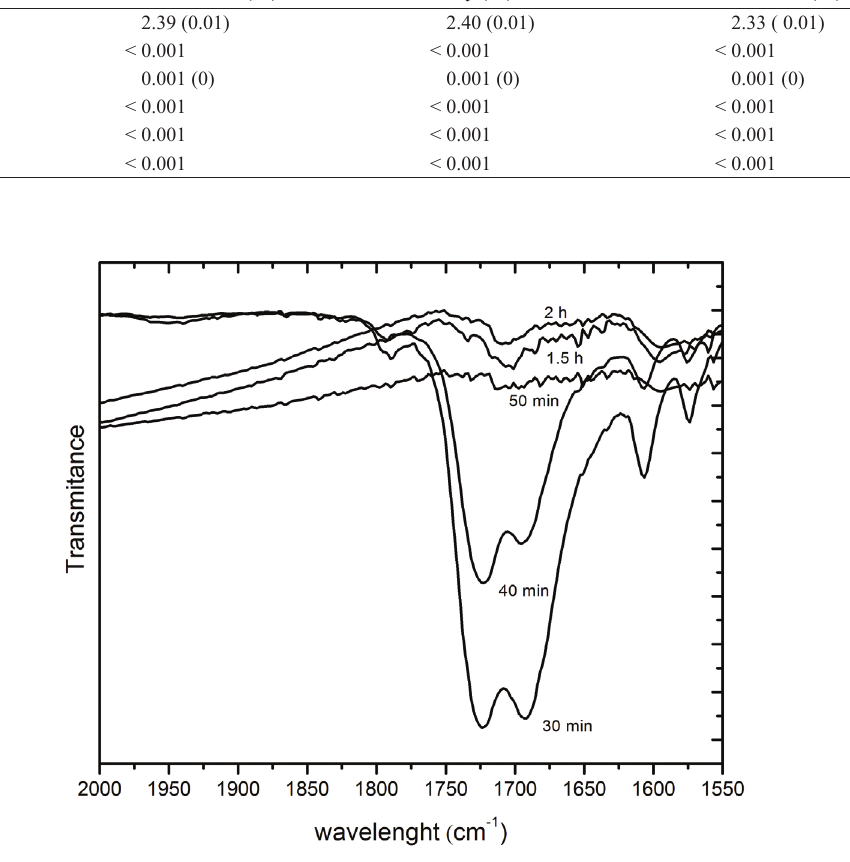
Table 1. Oxides Percentages found in the recovered material in the first and second stages. Analyzed Oxides